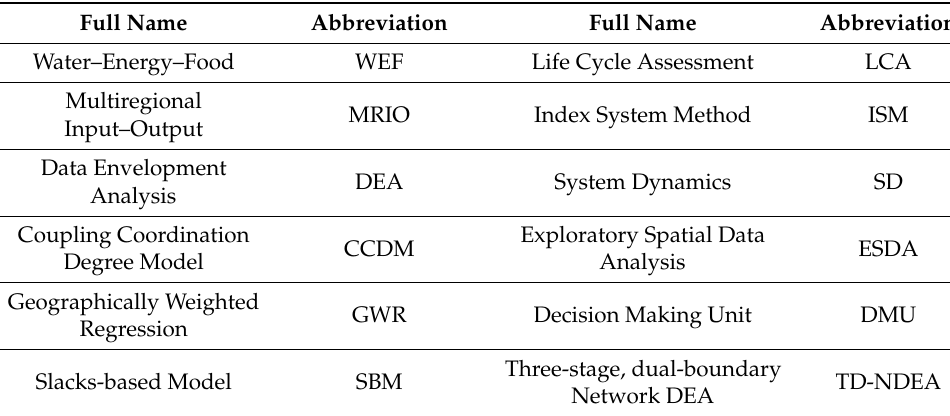
Table A1. Full names and abbreviations of